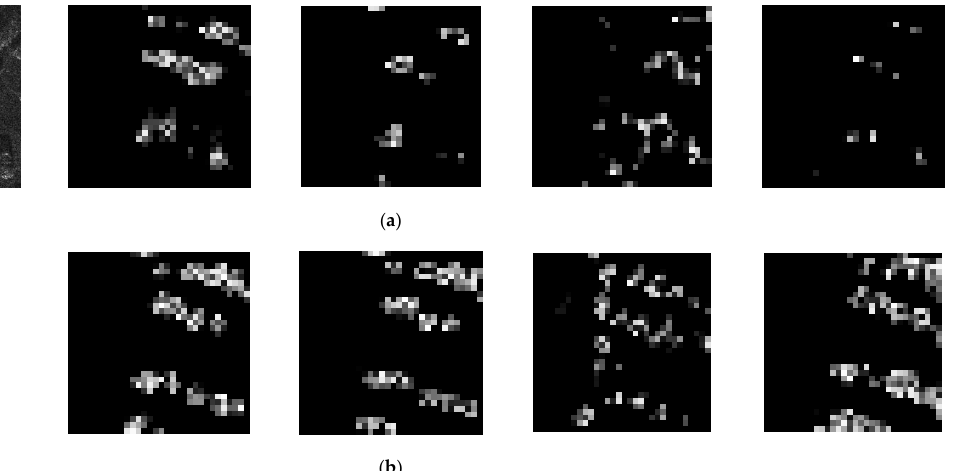
Figure 8. Examples of the feature maps from 4 channels in the conv5_3 layer for an image chip in the miniSAR test dataset. The first image in ( a ) shows the original image chip, and the other four images in ( a ) are the feature maps from 4 channels in the conv5_3 layer obtained by the original faster R-CNN; ( b ) shows the four corresponding feature maps obtained by the faster R-CNN with the decoder.